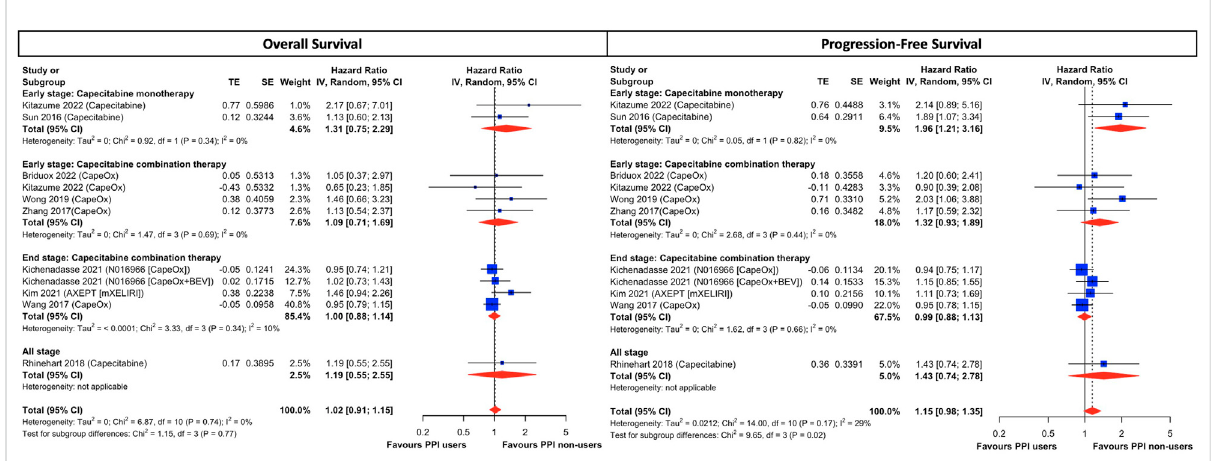
FIGURE 3 SubgroupanalysisofcancerstageandtreatmentcombinationinCRCpatientstreatedwithcapecitabine-basedregimens.Thesizeofsquaresis proportional to the weight of each study. Horizontal lines indicate the 95% CI of each study; diamond, the pooled estimate with 95%. PPI, proton pump inhibitors; CI, con fi dential interval; CRC, colorectal cancers; CapeOx, capecitabine plus oxaliplatin; mXELIRI, capecitabine plus irinotecan; BEV, bevacizumab.